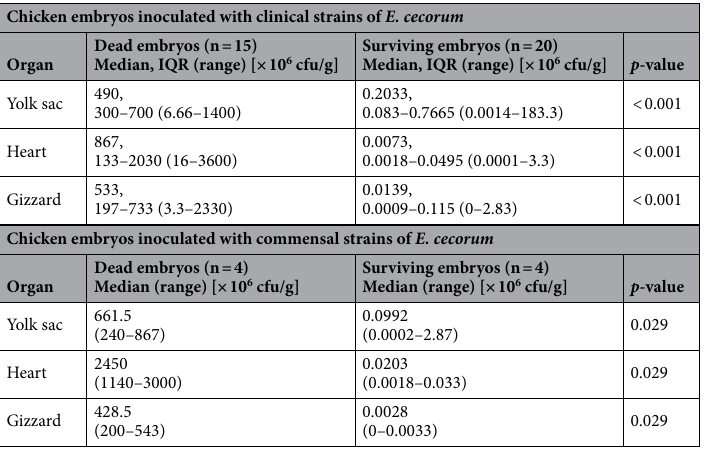
Table 5. Bacterial loads in the organs [cfu/g] of dead (13 di, 2 dpi) and surviving (18 di, 7 dpi) SPF chicken embryos inoculated with clinical or commensal Enterococcus cecorum strains (at dose approx. 3.4 × 10 7